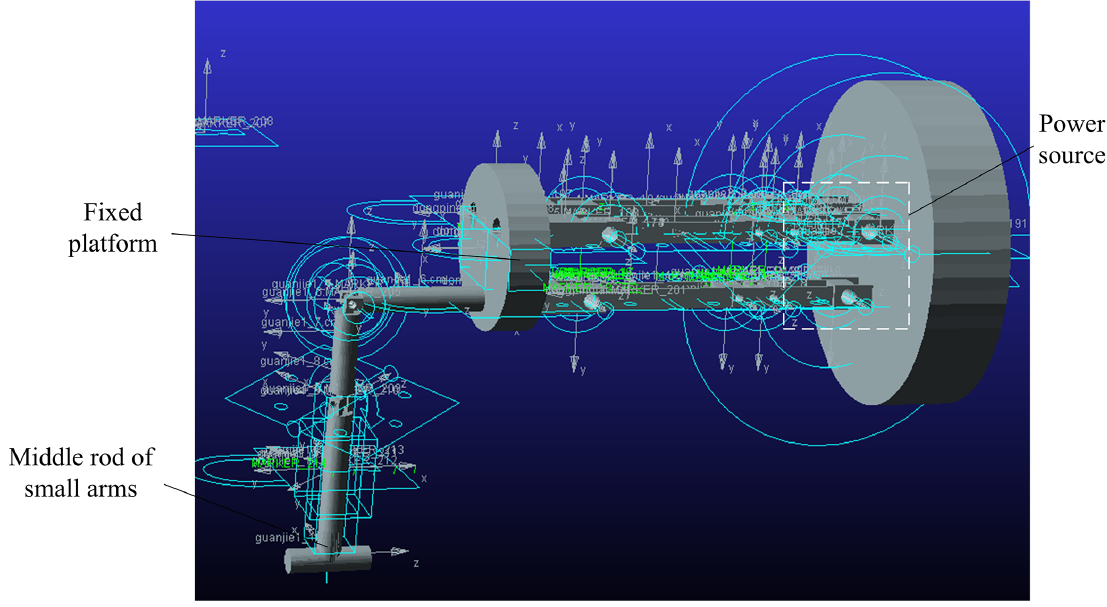
Figure 7. Winding robot boom, arm addition constraint and driving force